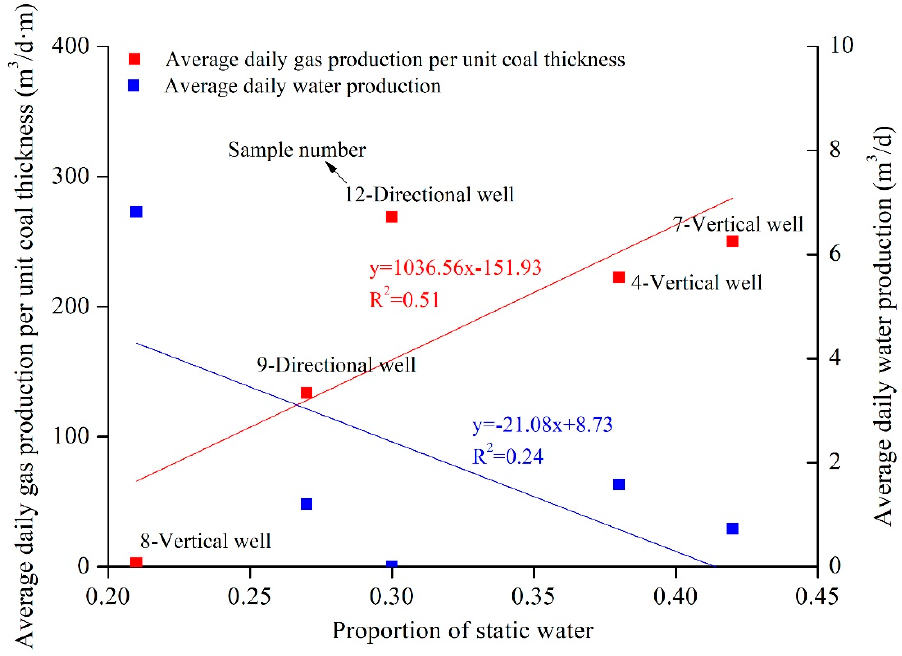
Figure 12. Relationships between the proportion of static water and gas/water production.